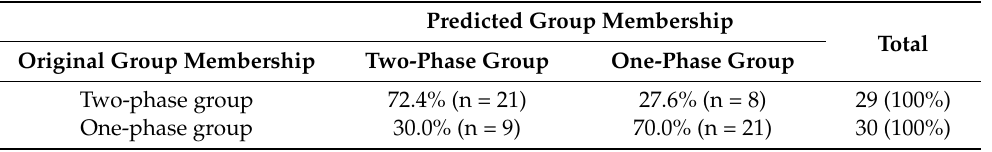
Table 6. Classification results of the stepwise discriminant